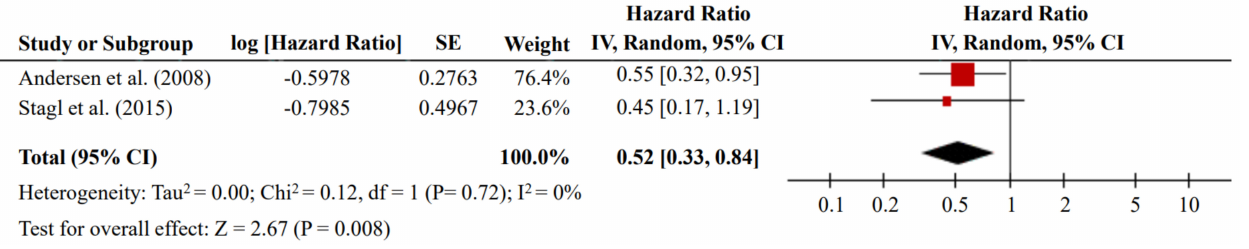
Figure 2. Meta − analysis of 2 RCTs. The size of the rectangle increases as the number of samples in each study increases and the confidence interval narrows. Diamond represents the overall outcome of the meta − analysis as a weighted average of included